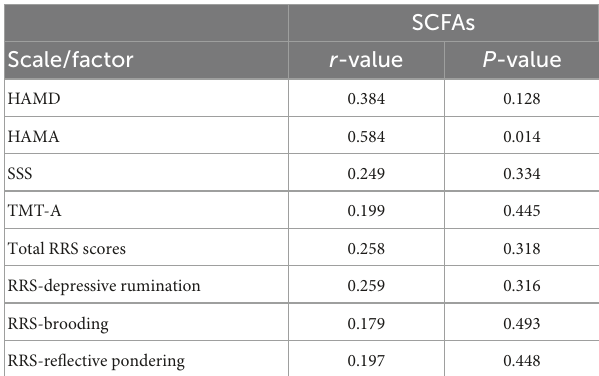
TABLE 4 Analysis of correlation between serum SCFAs content and clinical